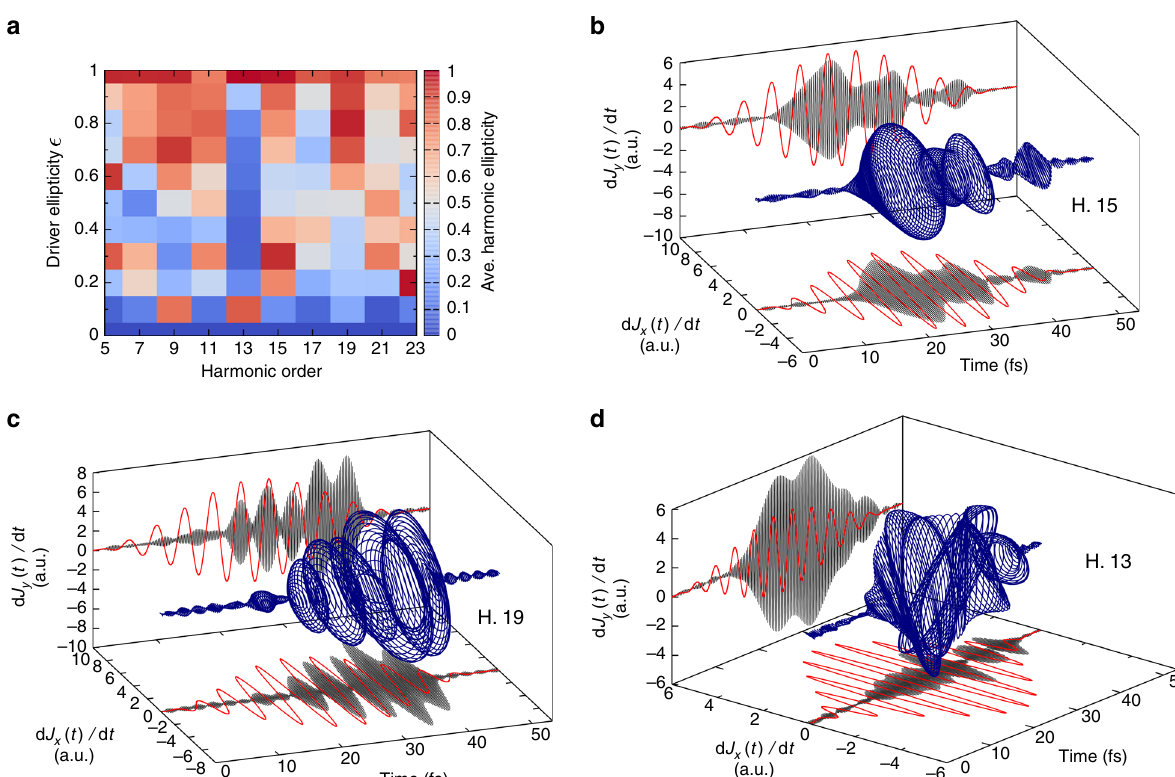
Fig. 6 Ellipticity of the emitted harmonics for bulk MgO. a Calculated average ellipticity of the harmonics emitted for the major axis along the Γ X direction, vs. the ellipticity of the driving fi eld. b Evolution of the time-derivative of the electronic current, bandpass fi ltered around the 15th harmonic (see “ Methods ” section), for circular polarization ( ϵ = 1). c Same as b , but for the 19th harmonic. d Same as b and c , but for the 13th harmonic and ϵ =